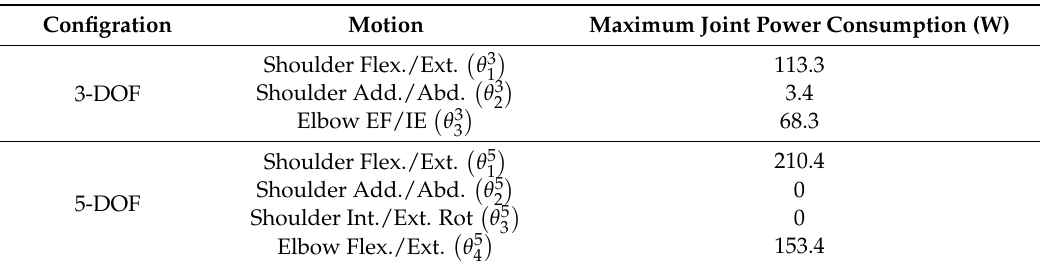
Table 10. Maximum joint power consumption.